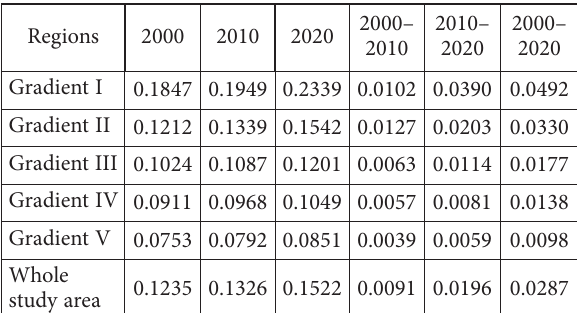
Table 5. Changes of the human activity intensity in Guiyang Regions